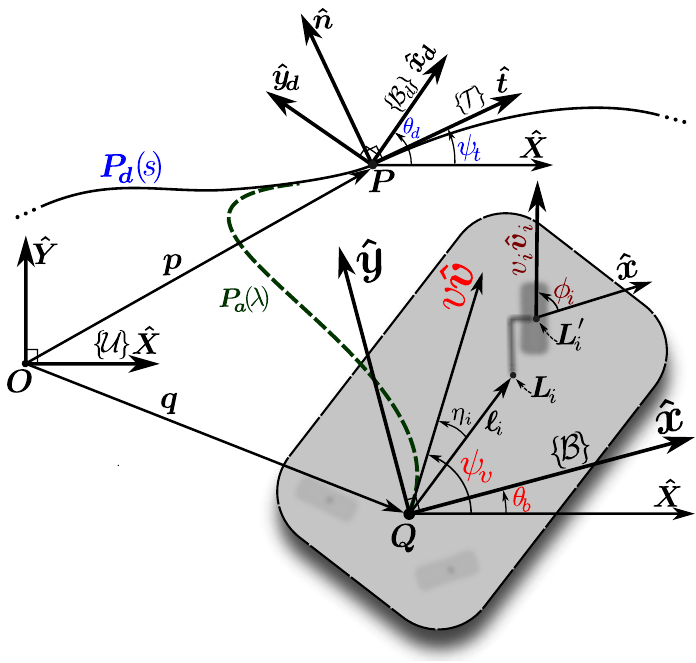
Figure 1. The desired path and the required coordinate